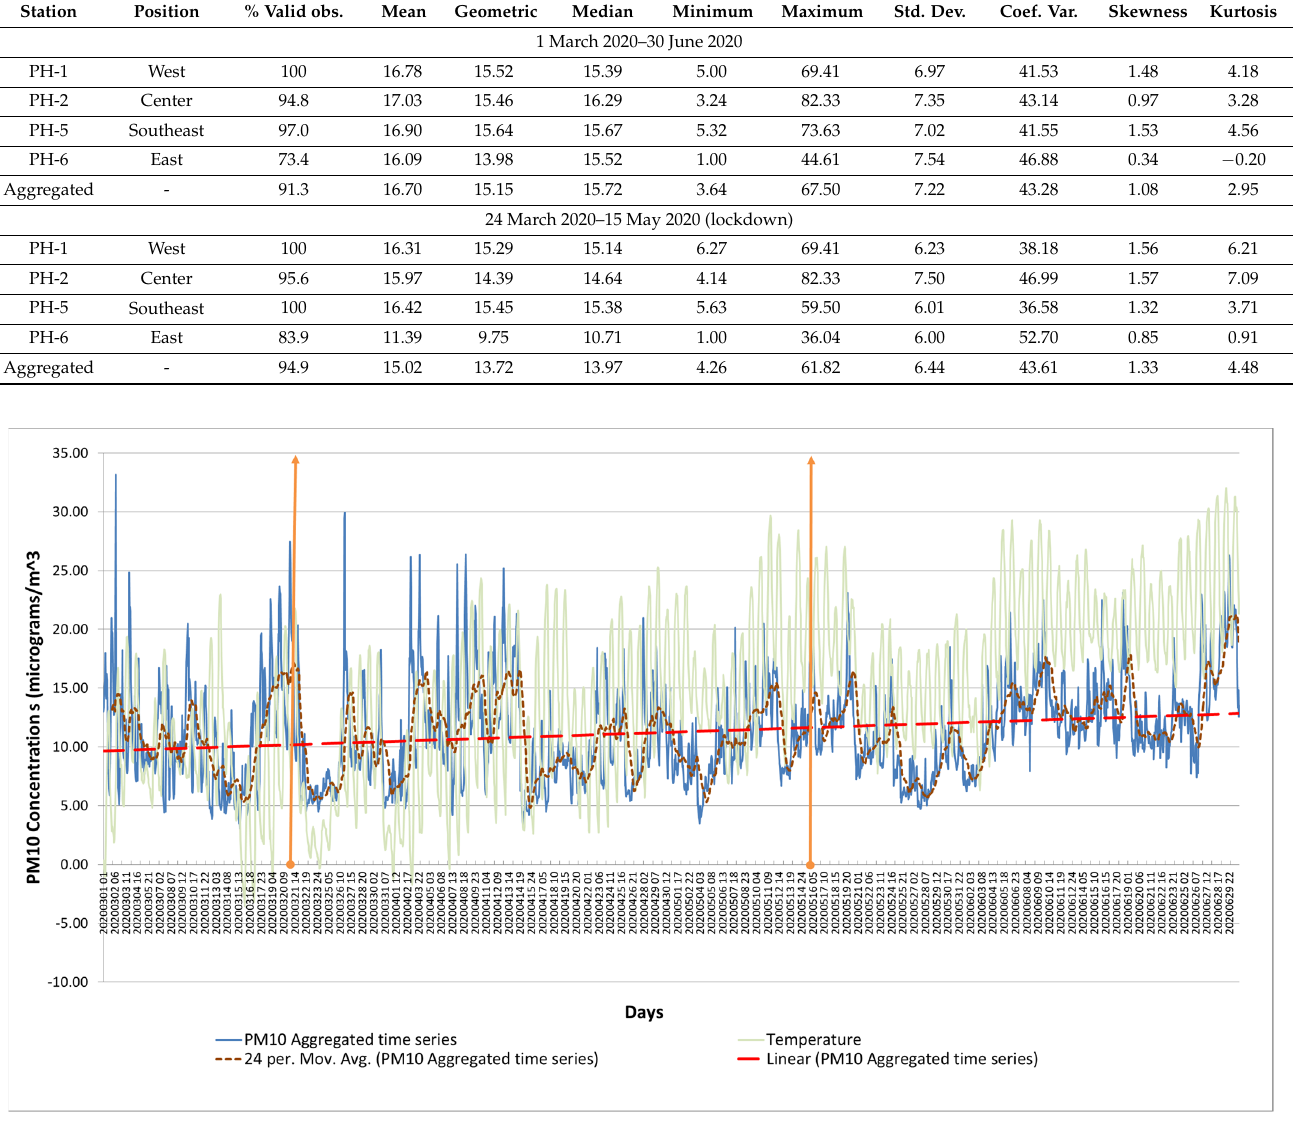
Figure 5. Aggregated PM10 time series, its moving average and trend line between 1 March and 30 June 2020, including the main lockdown period (between the orange lines) resulted from the data recorded by the automatic stations (LSPM10 Unitec optical analyzers) located in Ploiesti, and hourly temperature (°C) retrieved from the ERA 5 reanalysis dataset.